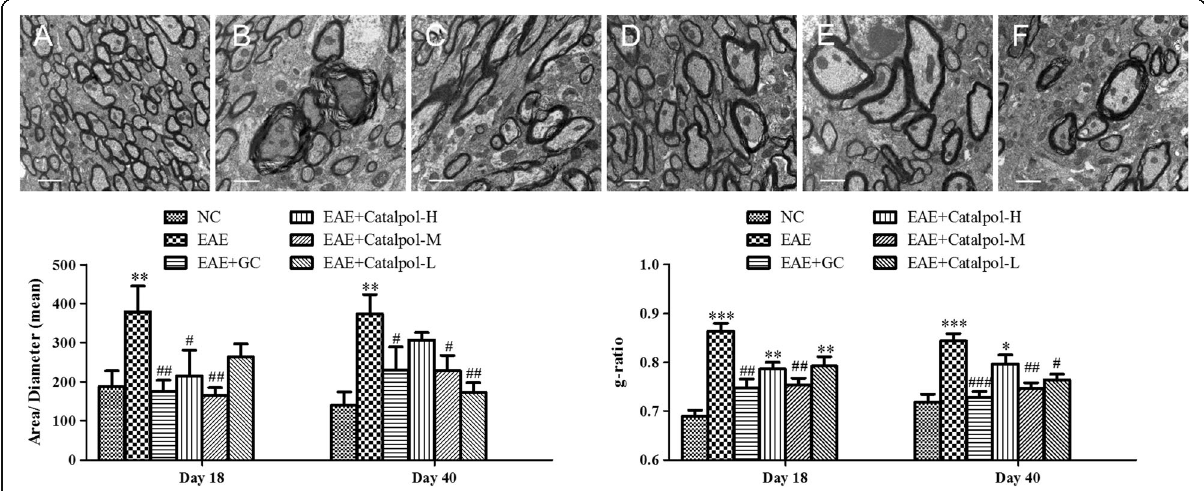
Fig. 4 Observation of pathological changes (Area/Diameter) and remyelination (g-ratio) in the brains of mice under the TEM. a to f show the demyelination in the brains of mice on Day 40 in NC ( n = 4), EAE ( n = 4), EAE+ PA ( n = 4), EAE + Catalpol – H ( n = 4), M ( n = 4) and L ( n = 4) mice, respectively (scale bar 1 μ m). The EAE mice showed a fluffy layer structure, axonal edema and disintegration (arrows). Demyelination was lighter in PA and Catalpol-treated EAE mice ( arrows ). Note: * P < 0.05, ** P < 0.01, *** P < 0.001 vs. NC; # P < 0.05, ## P < 0.01, ### P < 0.001 vs.